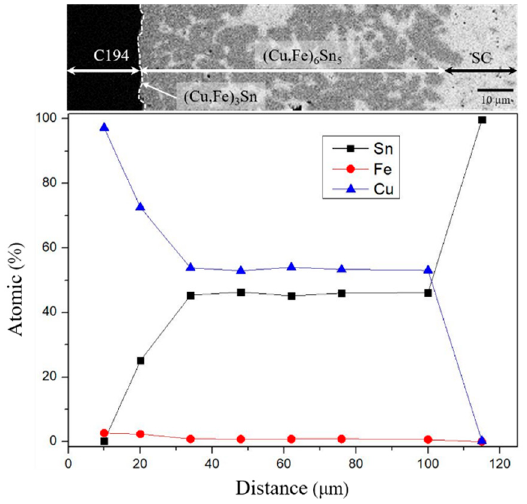
Figure 3. EPMA line scan and corresponding BEI micrograph of SC/C194 reaction couple at a reaction temperature of 240 ◦ C and reaction time of 5